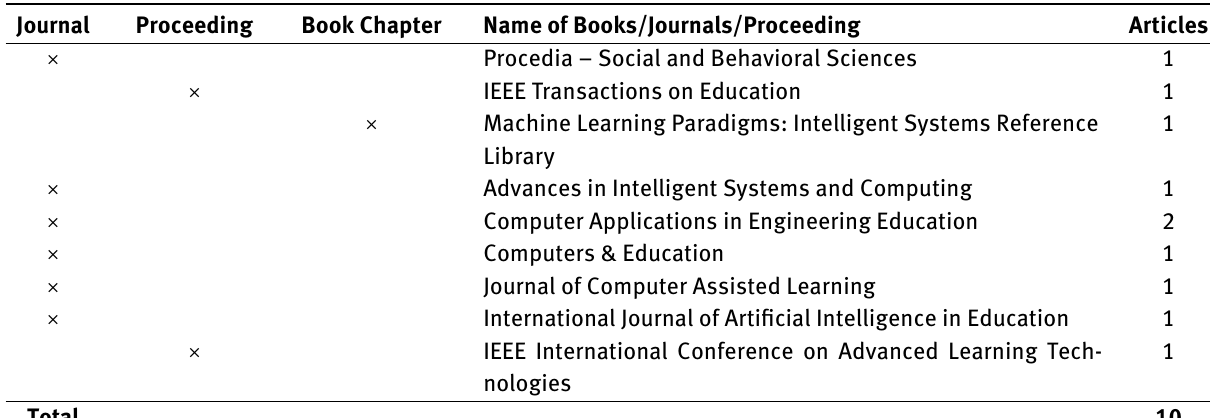
Table 1: The number of reviewed papers based on types